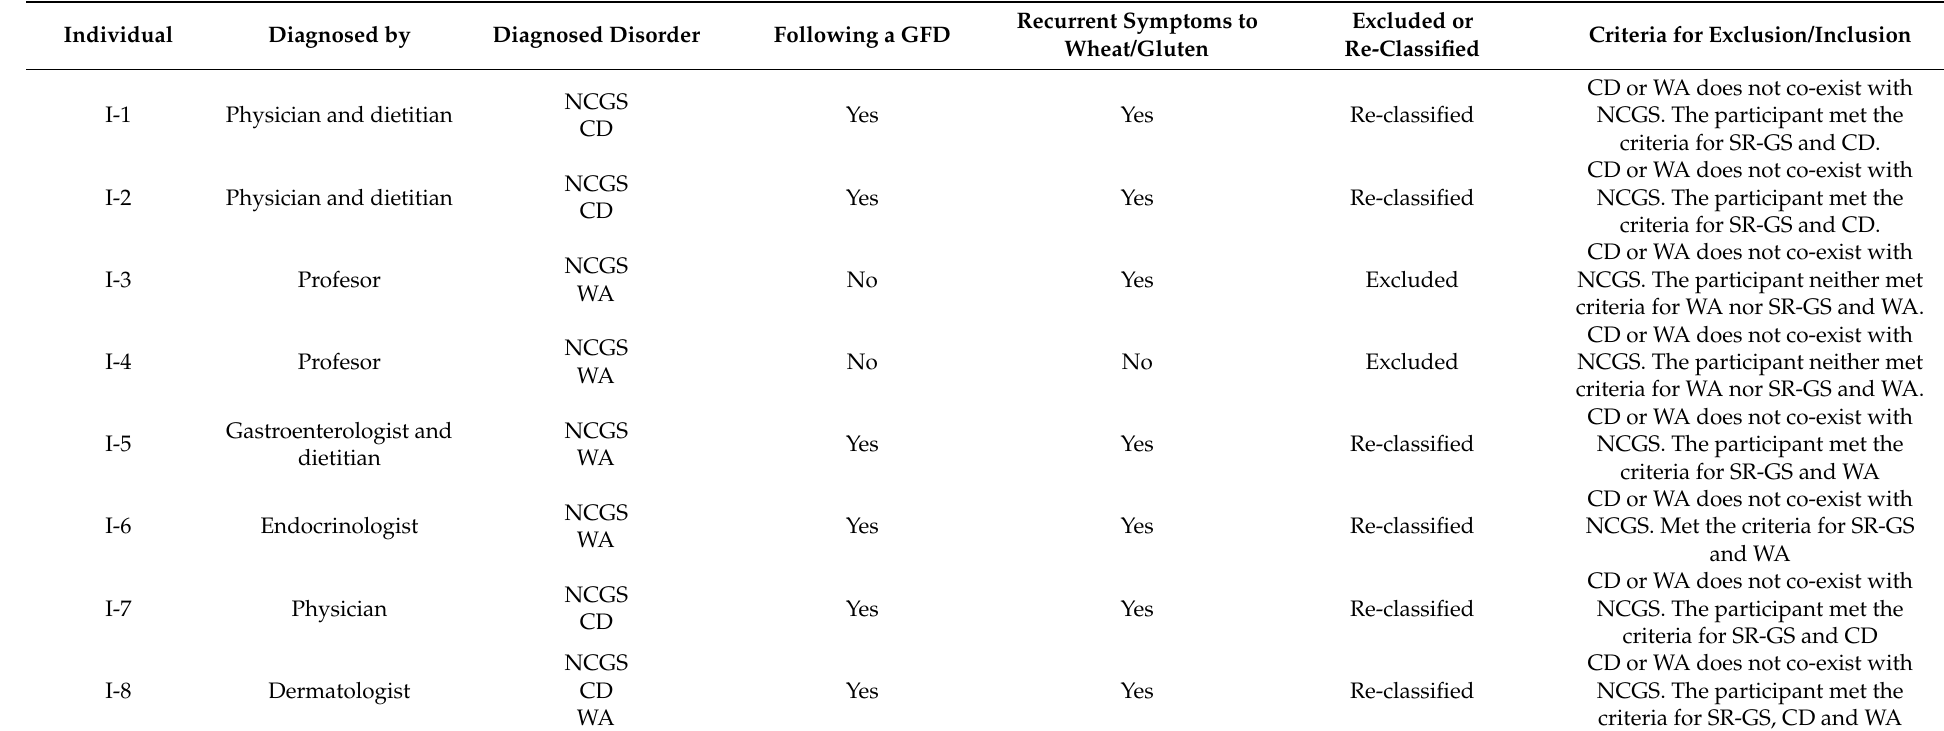
Table 3. Characteristics of the physician-diagnosed individuals who reported the coexistence of NCGS with other gluten-related disorders.